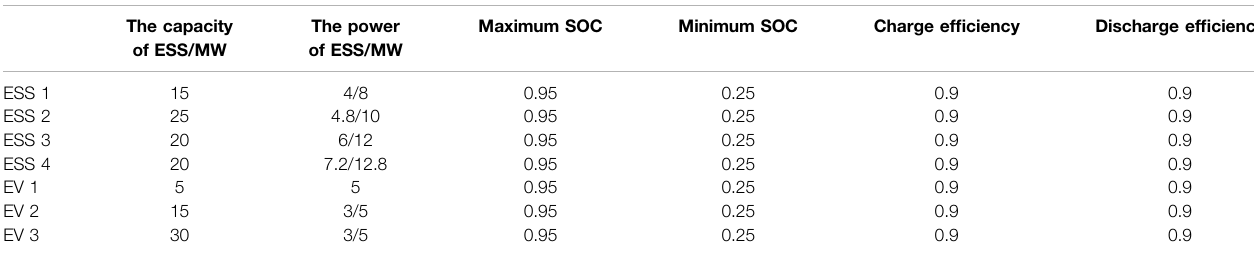
TABLE 2 | Parameters of internal resources of the virtual power